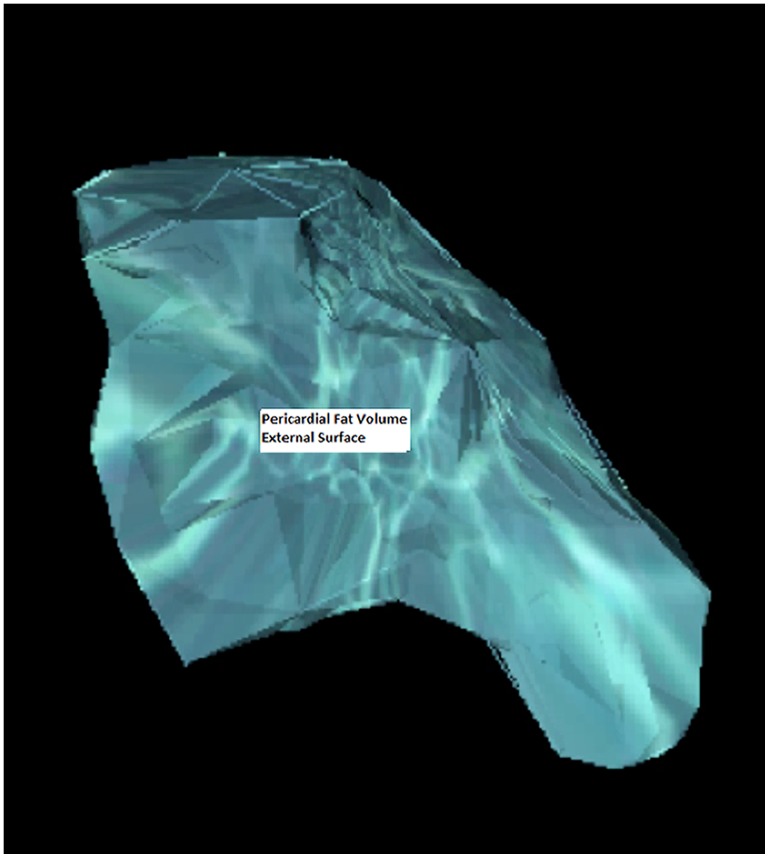
Pericardial fat volume, antero-posterior external view of its tridimensional reconstruction.